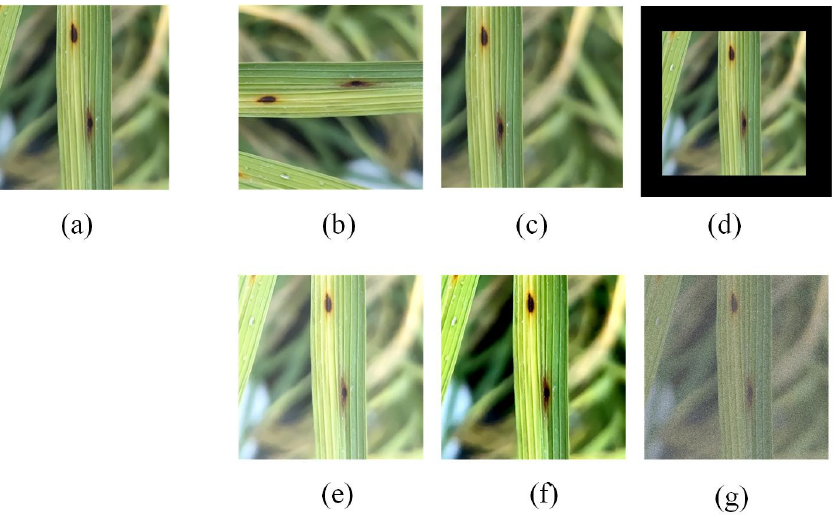
Figure 9. TIDA approach, where ( a ) is the original image, ( b ) rotation, ( c ) panning, ( d ) scaling, ( e ) brightness adjustment, ( f ) contrast adjustment, and ( g ) adding